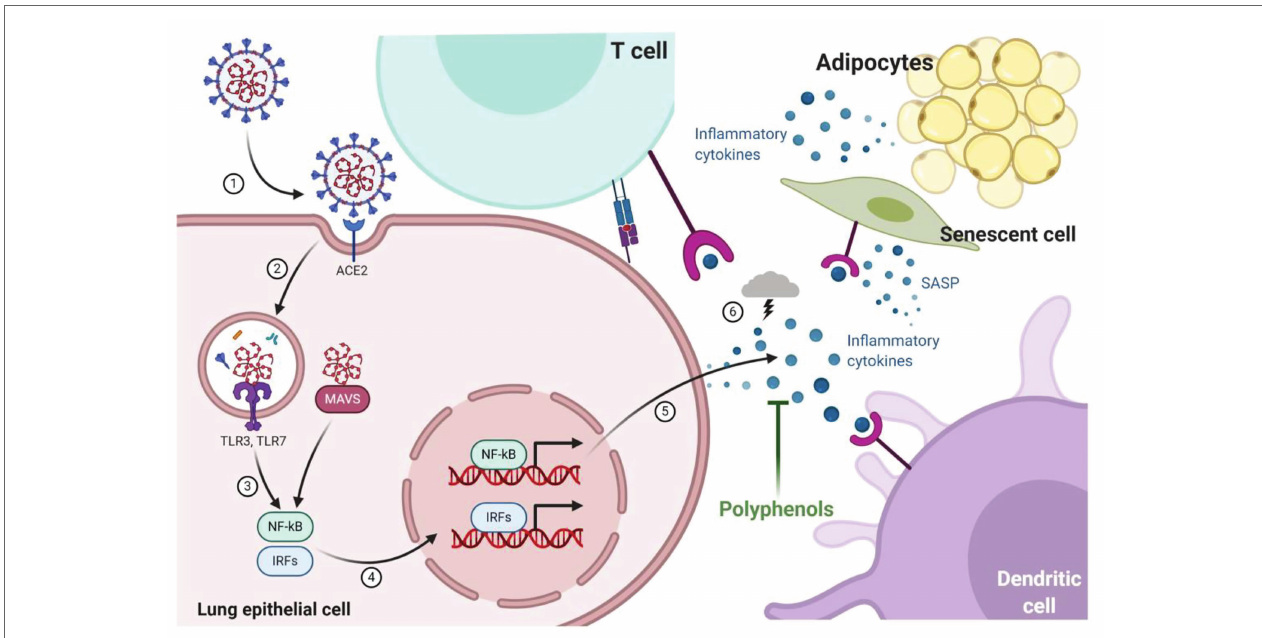
FIGURE 1 | Infection of pulmonary epithelial cells occurs through the interaction of the spike glycoprotein envelope (S-protein) with the angiotensin I converting enzyme (ACE)-2 receptor that allows viral replication and triggers mechanisms to combat infection by the host cells thought toll-like receptors (TLRs) and mitochondrial antiviral-signaling protein (MAVS). Cytokines pro-inflammatory are produced by nuclear factor kappa -B (NF-kB) and interferon-regulatory factors (IRFs) signaling pathways recruiting more immune cells (dendritic cell and T-cell) to lungs. Recruited immune cells increased cytokine production resulting in a cytokine storm that is associated with a worse prognosis of infected patients. During aging and obesity, the production of pro-inflammatory cytokines and the establishment of low-grade systemic inflammation are also observed. The expression of components of the renin-angiotensin-aldosterone system, such as ACE2, is also modified by aging and obesity, which could explain why elderly and obese patients are affected and headed the death statistics by COVID-19. Dietary bioactive substances such as polyphenols are able to block the production of cytokines by senescent cells (senescence-associated secretory phenotype; SASP) and adipocytes, as well as modify the ACE-1/ACE-2 ratio, which can potentially result in beneficial effects in